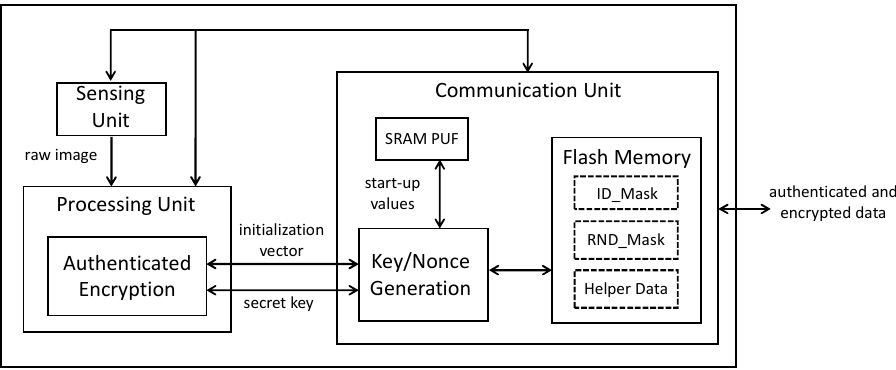
Figure 1. Block diagram of a trusted camera based on SRAM PUFs.